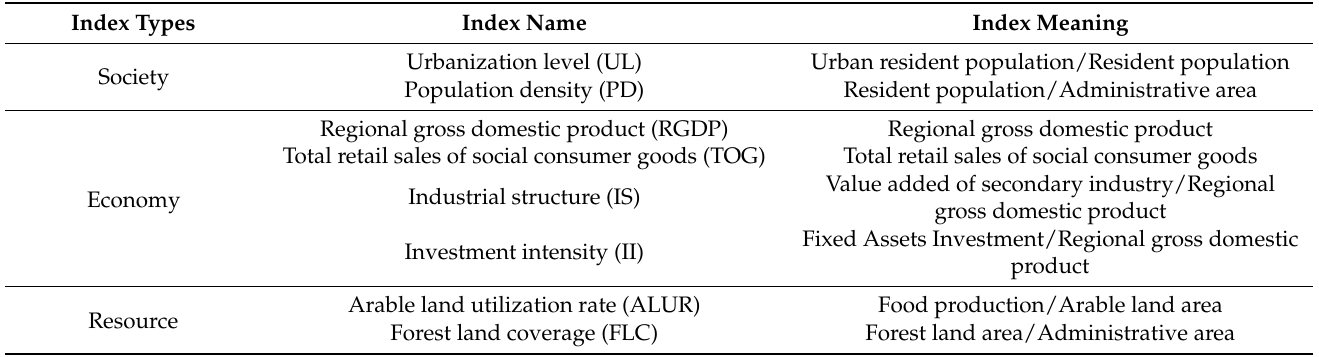
Table 2. Evaluation index system of influencing factors of